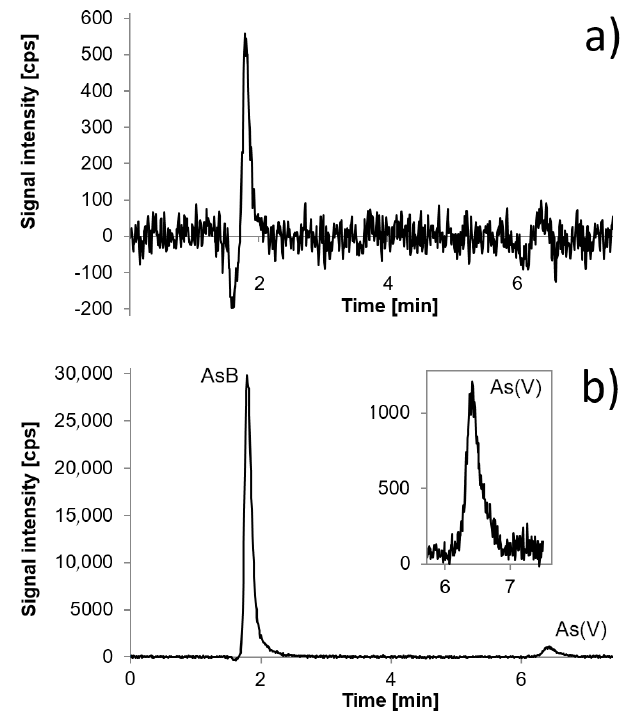
Figure 6. Chromatograms of exemplary freshwater fish samples: ( a ) from Wielkopolska province; ( b ) from Lower Silesia province.